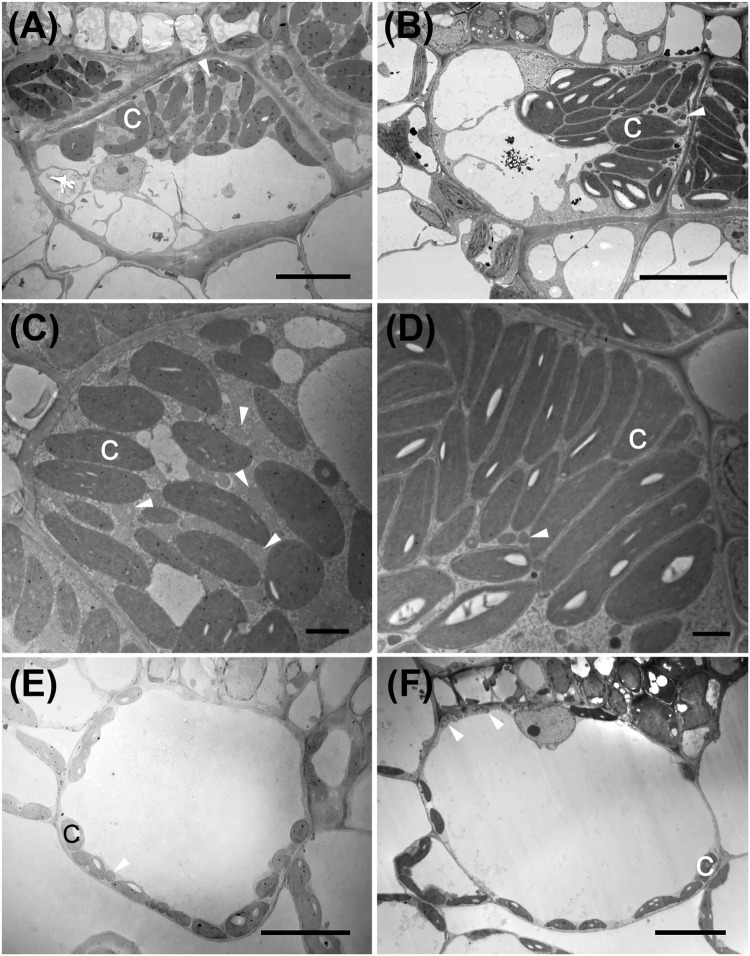
Transmission electron micrographs illustrating bundle sheath cells of C3 and C4 Nyctaginaceae species from the tribe Nyctagineae. (A–D) C4 species; (A,C)
Allionia incarnata, (B,D); Boerhavia coccinea; (C,D) high magnification images of the bundle sheath cells. Note high numbers of mitochondria in Allionia incarnata
(C). (E,F) The C3 species Commicarpus scandens
(E), and Nyctaginia capitata
(F). C, chloroplast; arrowheads mark mitochondria. Scale bars = 10 μm.